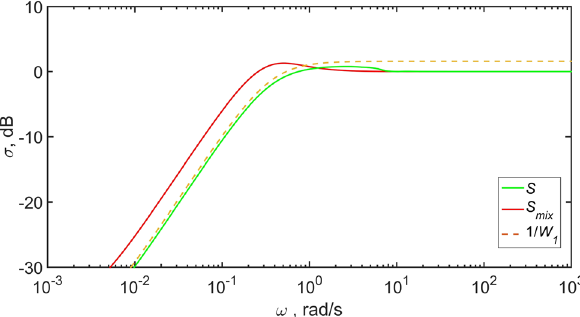
Figure 15: Sensitivity